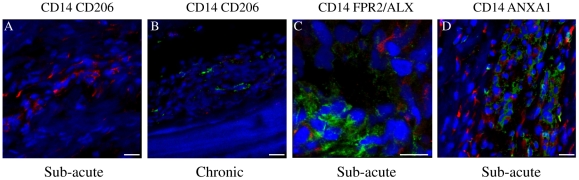
Panel of representative 3-dimensional reconstructed Z stack immunofluorescent images of injured SDFT sections.(A) Dual labelled CD14 (red) and CD206 (green) showing predominance of CD14high Mϕ in sub-acute tendon injury. Scale bar = 20 µm. (B) Dual labelled CD14 (red) and CD206 (green) showing predominance of CD206high Mϕ in chronic tendon injury. Scale bar = 20 µm. (C) Dual labelled CD14 (red) and FPR2/ALX (green), showing FPR2/ALX expression by tenocytes but not M1Mϕ in sub-acute tendon injury. Scale bar = 12 µm. (D) Dual labelled CD14 (red) and Annexin A1 (green), showing Annexin A1 expression by tenocytes but not M1Mϕ in sub-acute tendon injury. Scale bar = 20 µm. Blue represents Hoechst nuclear counter stain.